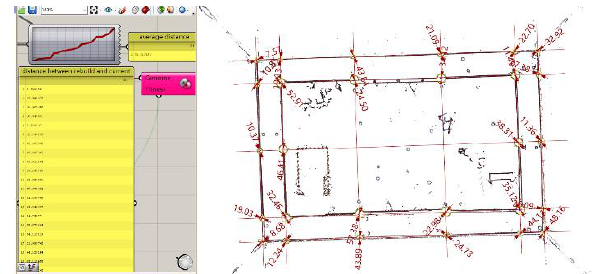
Figure 144. the grid system of the second floor